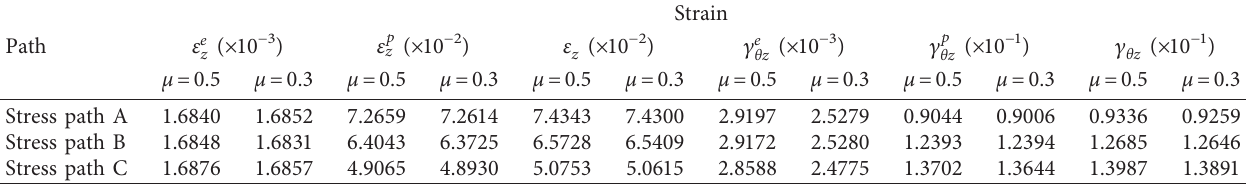
Table 1: FEA results of stress paths A, B, and C.